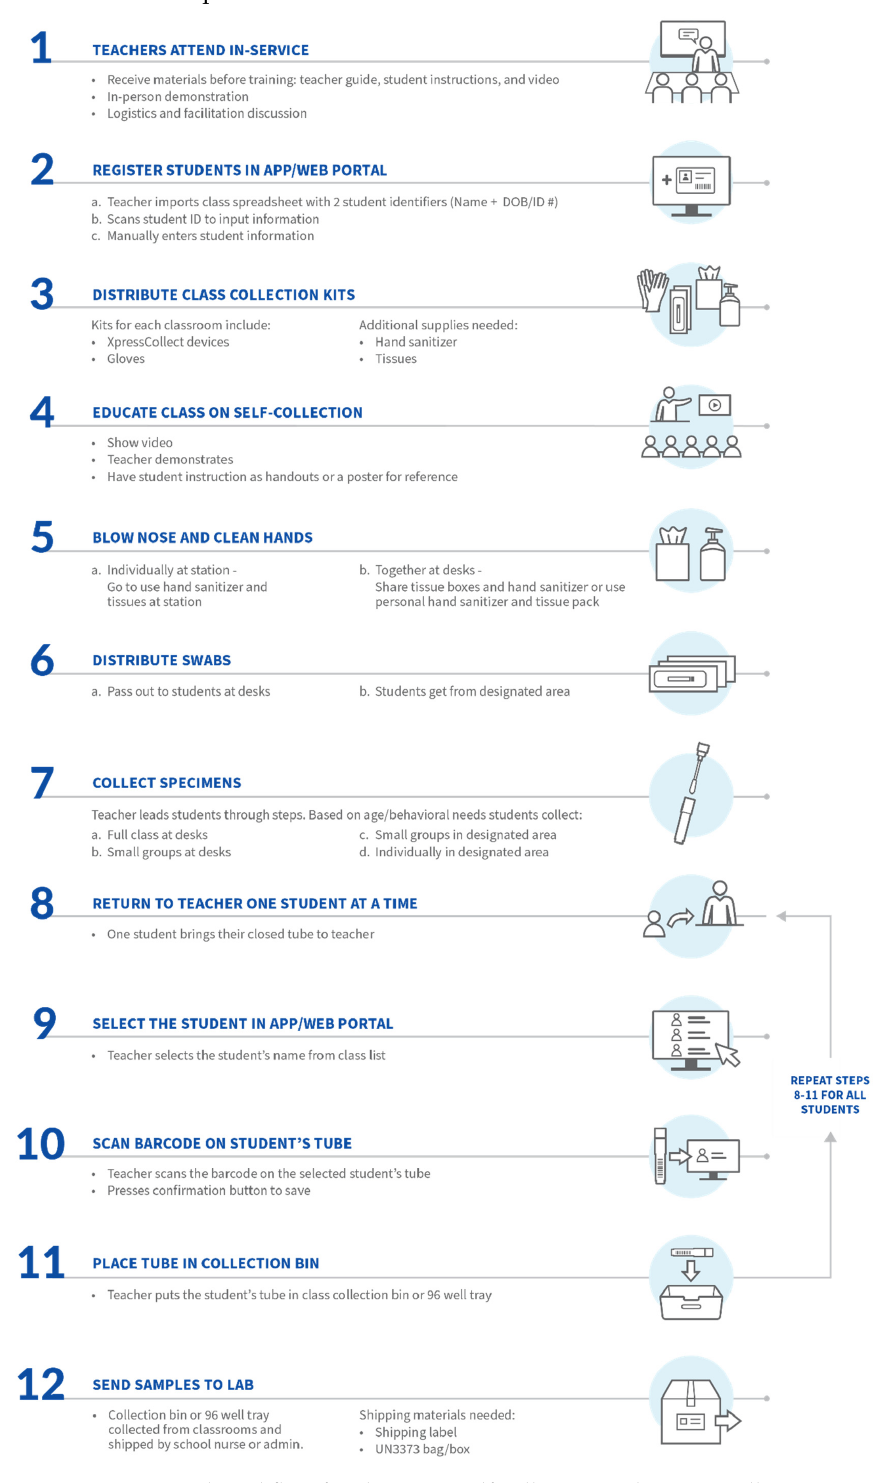
Figure 11. Proposed workflow for classroom self-collection with XpressCollect.